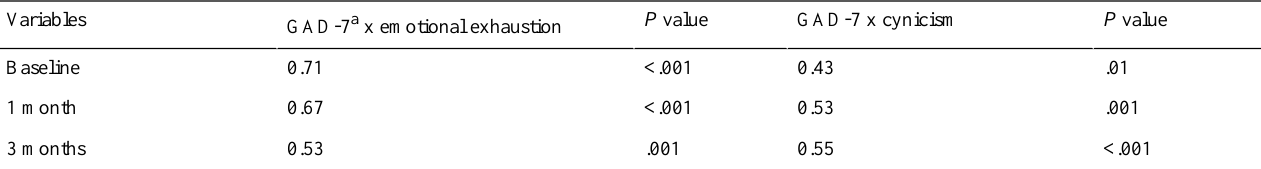
Table 1. Correlations between anxiety and burnout scores at baseline, 1 month, and 3 months after initiating mindfulness